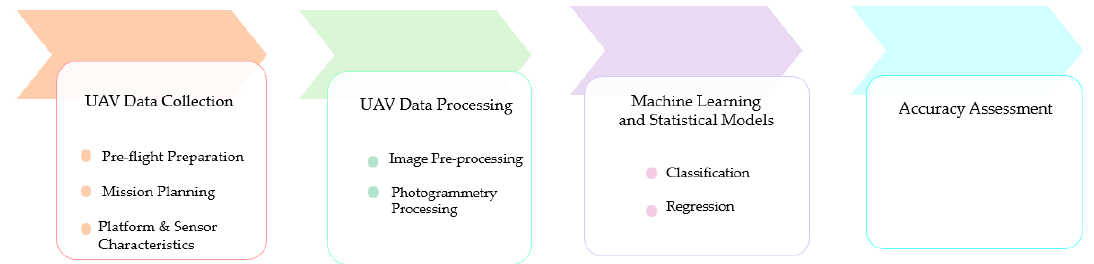
Figure 1. Data processing Workflow.